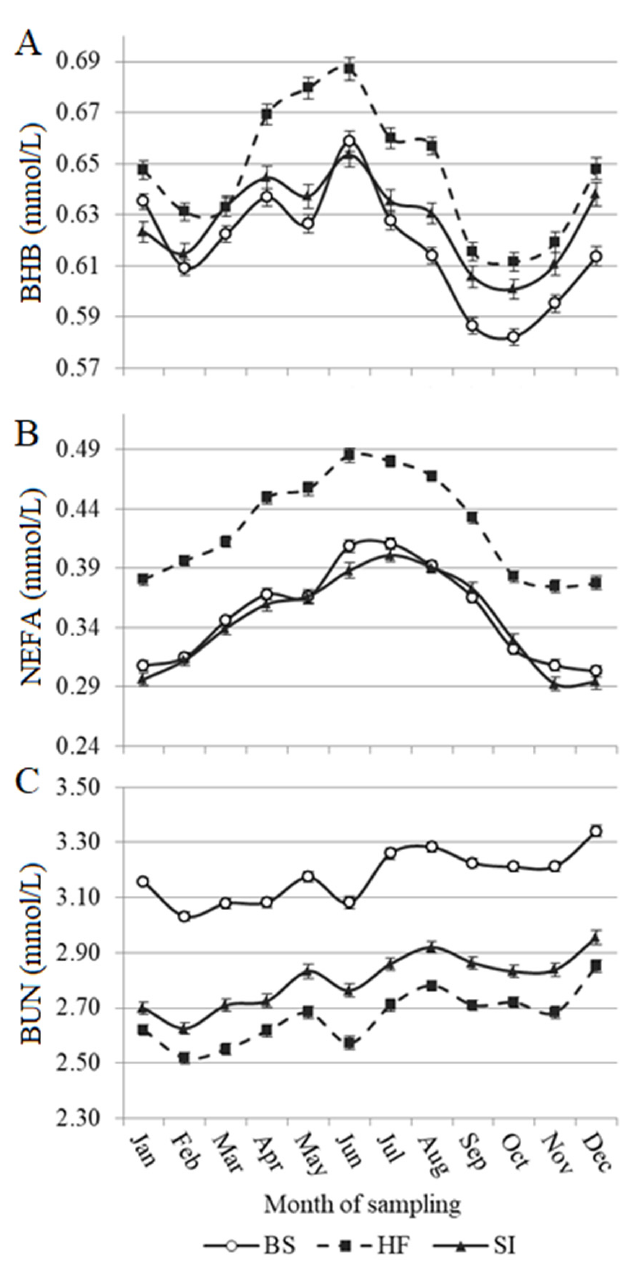
Figure 3. Least squares means of predicted ( A ) blood β -hydroxybutyrate (BHB), ( B ) blood non-esterified fatty acids (NEFA), and ( C ) blood urea nitrogen (BUN) across months of sampling in Brown Swiss (BS), Holstein-Friesian (HF), and Simmental (SI) cows in multi-breed herds. Log 10 -transformed BHB was the trait analyzed as dependent variable in the mixed model; however, for clarity of presentation, least squares means were back-transformed to present results in mmol / L. Vertical bars indicate the standard error.